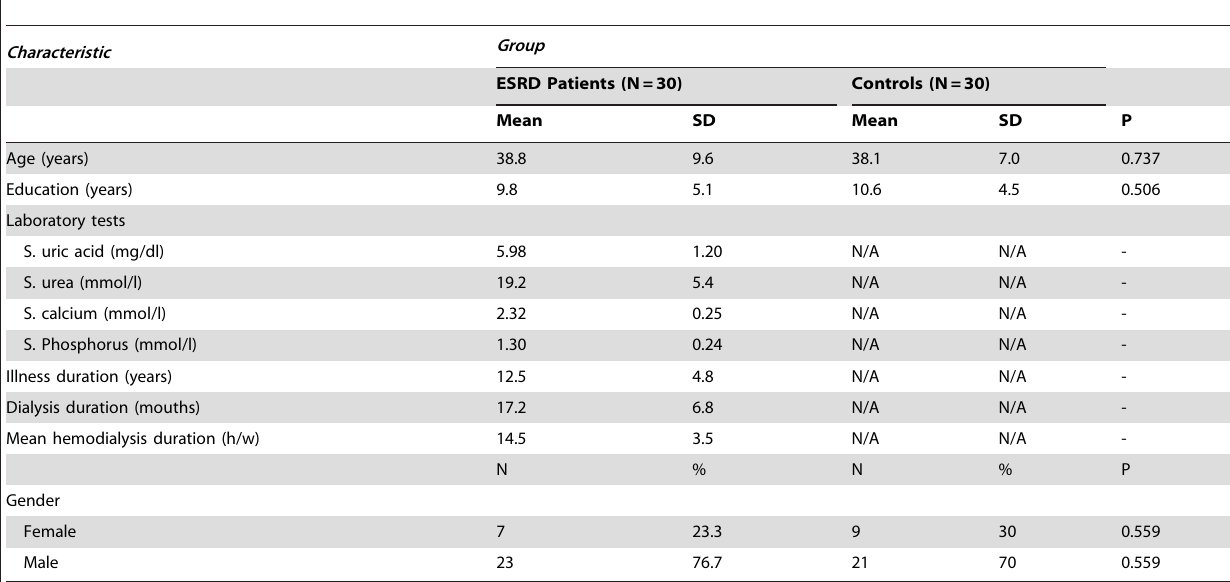
Table 1. Demographic and Clinical Characteristics for End Stage Renal Disease (ESRD) Patients and Controls.